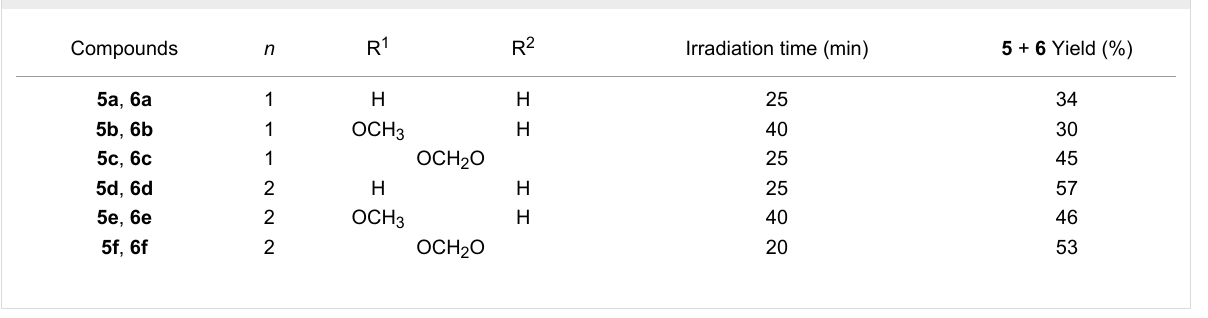
Table 1: Benz[ f ]indenes 5 and 6